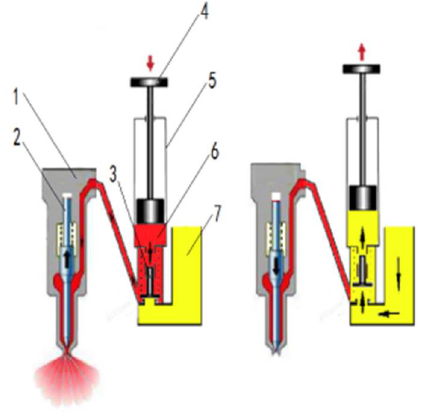
Figure 2. The schematic diagram of the spraying method: 1—sprayer shell; 2—needle valve; 3—one-